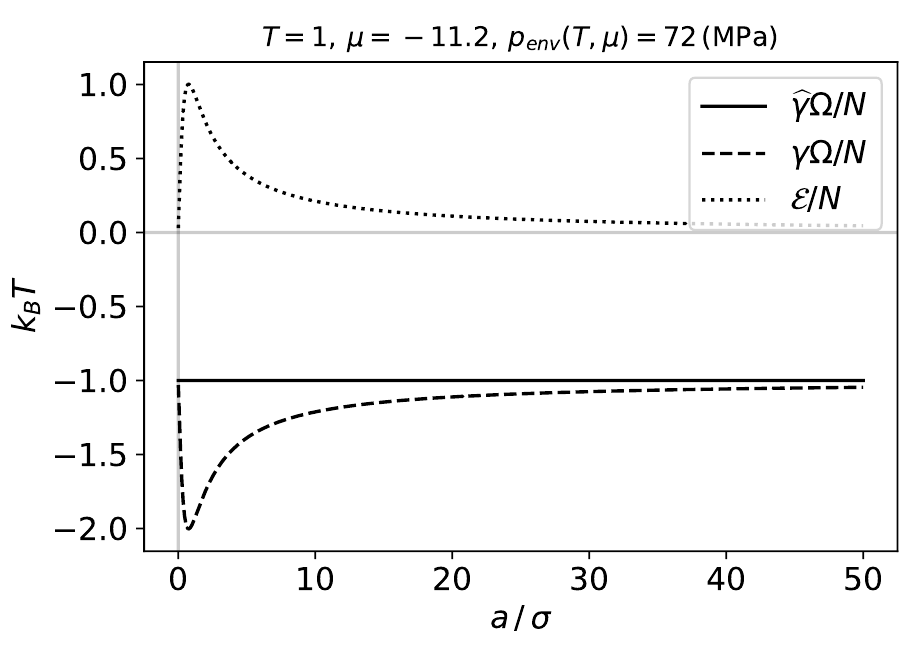
Figure 3. Adsorbed phase thermodynamic quantities per molecule at constant temperature and chemical